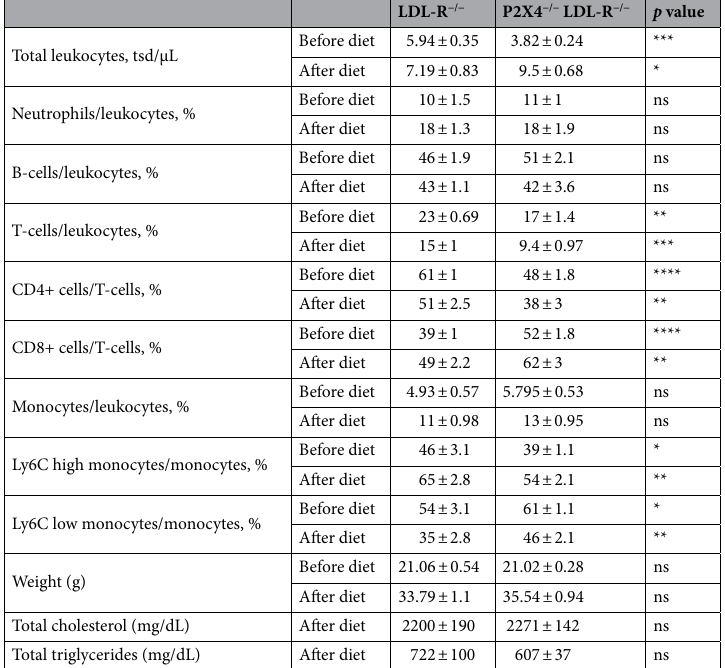
Table 1. Baseline characteristics P2X4-Knockout Study. Blood was taken from P2X 4 −/− LDLR −/− mice (n = 24) and P2X 4 +/+ LDLR −/− mice (n = 15) before and after 16 weeks of high-cholesterol diet, leukocytes were measured in tsd/ul. Leukocyte subsets were analyzed before and after diet by fluorescence-activated cell sorting. Weight was taken before and after diet in P2X 4 −/− LDLR −/− mice (n = 24) and P2X 4 +/+ LDLR −/− mice (n = 15). Plasma total cholesterol and total triglycerides were assessed after diet. Results are presented as mean ± SEM. Statistical significance was calculated using an unpaired t-test for parametric or Mann–Whitney- U-test for non-parametric data. * p < 0.05; ** p < 0.01; *** p < 0.001; **** p <